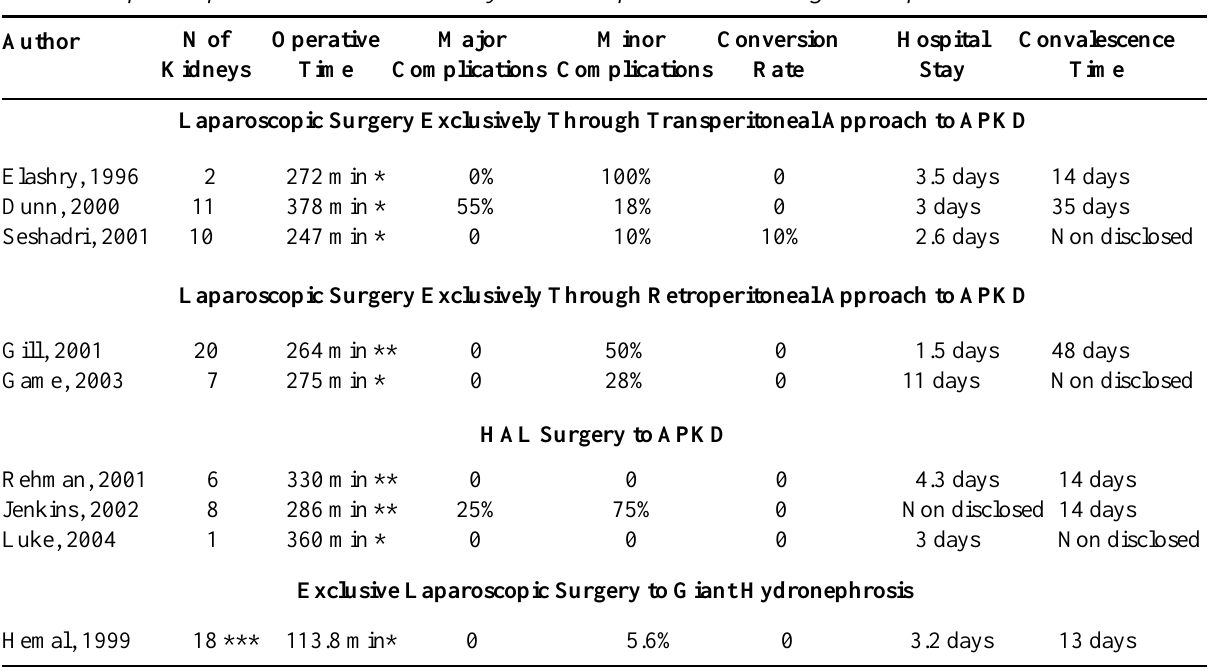
HAL = hand-assisted laparoscopic access; APKD = adult polycystic kidney disease; * operative times corresponding to unilateral nephrectomy; ** operative times corresponding to bilateral nephrectomies; *** 6 procedures performed through transperitoneal laparoscopic access and 12 procedures through retroperitoneal laparoscopic